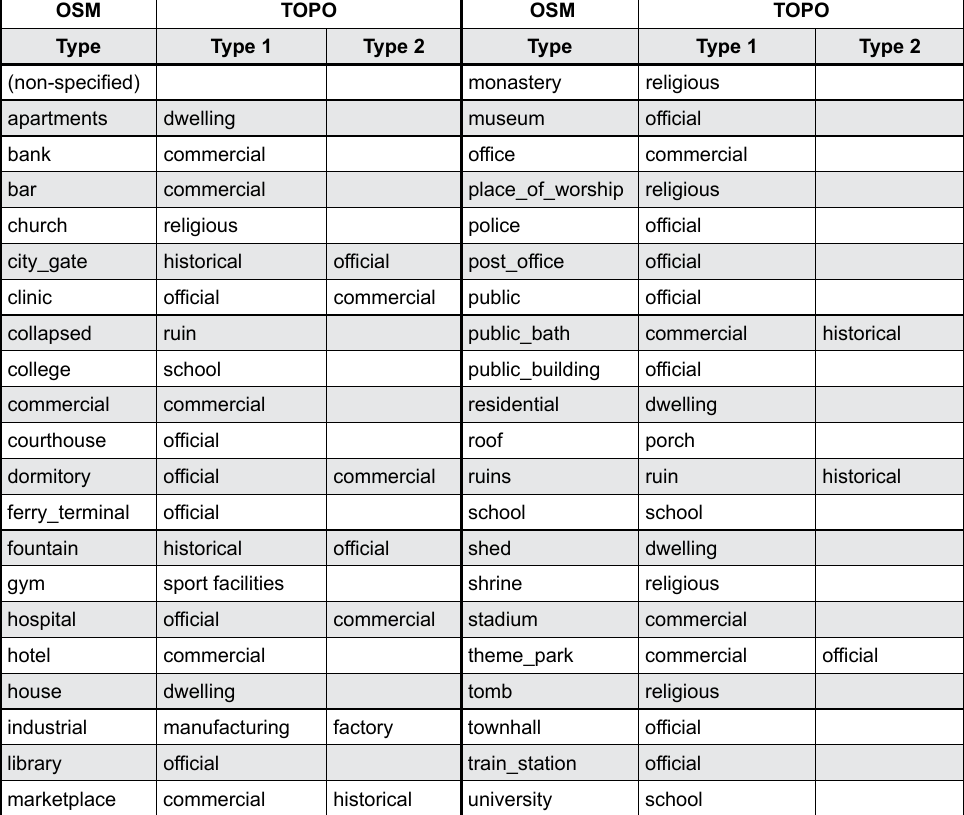
Table 1. Corresponding classes between OSM and TOPO datasets in the semantic match table OSM TOPO OSM